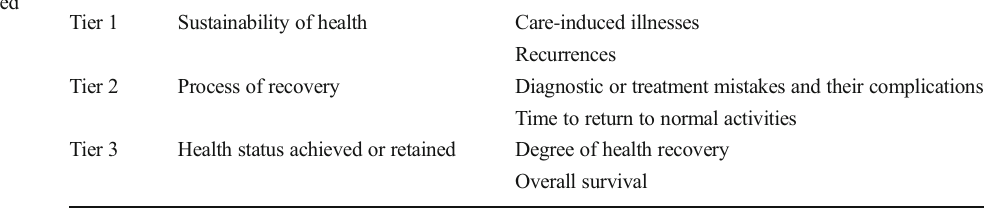
Table 1 Measuring value-based